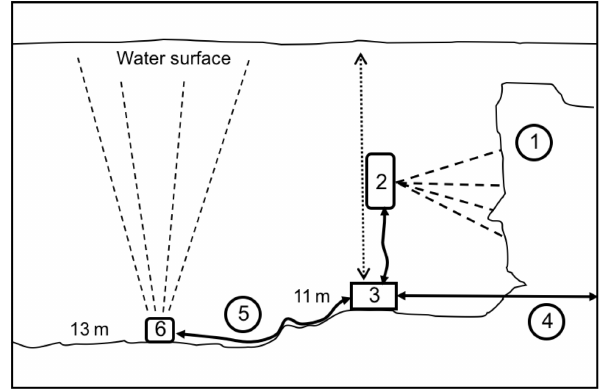
Figure 2. Sketch of the underwater installations with the underwa- ter base station and the vertical profiling unit off NyÅlesund. Num- bers refer to numbers in the sketch. (1) Steep wall (drop-off) with vertical zonated macrophyte coverage. (2) Vertical profiling sensor carrier with CTD and a stereo-optical imaging device (RemOs1) looking towards the wall. (3) Underwater node with wet-matable plugs. (4) Combined power/fibre-optic cable to land. (5) Combined power/rs232 cable from node to ADCP. (6) ADCP. For details on the single components, see the